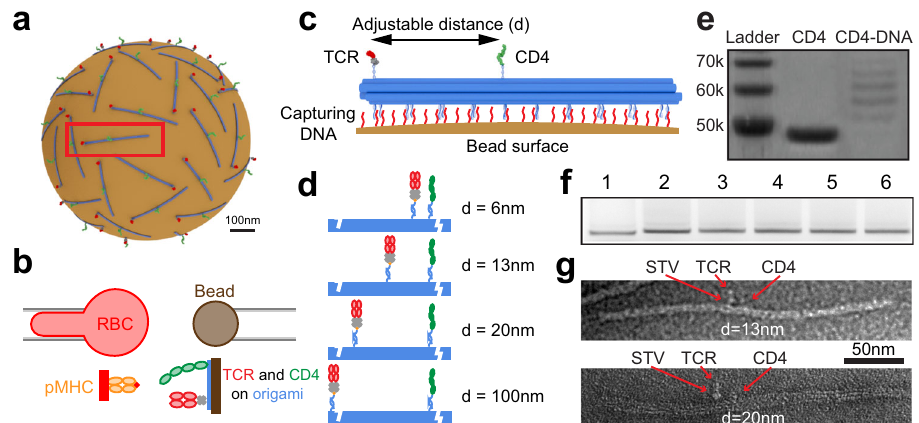
Fig. 4 | DNA origami-based platform for spacing control of TCR and CD4. a Schematic of “ surrogate ” T cell – magnetic bead bearing 10 HB origami functio- nalizedwithpreciselyspacedTCR and CD4. b Schematic of micropipette adhesion frequency assay combined with ligand presentation by origami. c 10 HB origami controls separation distance of TCR and CD4 and attaches to magnetic bead via DNA strand hybridization. TCR binds to a streptavidin (SA), which also binds to a biotinylatedDNAstrandthat hybridizeswithaTCR-capturing DNAstrandon10HB origami. CD4 is covalently conjugated with a DNA stand that binds to a CD4- captruing strand. d Four distances were employed,witheither6, 13,20, or 100nm